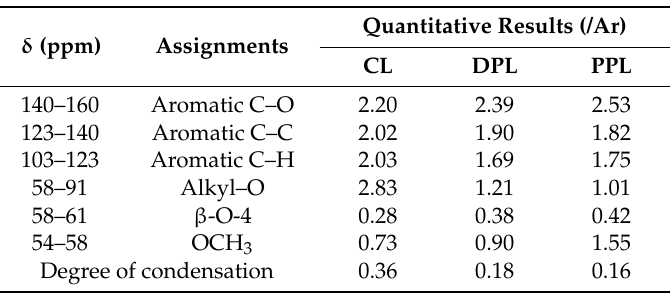
Table 2. The assignments and quantitative results of main chemical shifts in 13 C NMR spectra of CL, DPL and PPL samples.